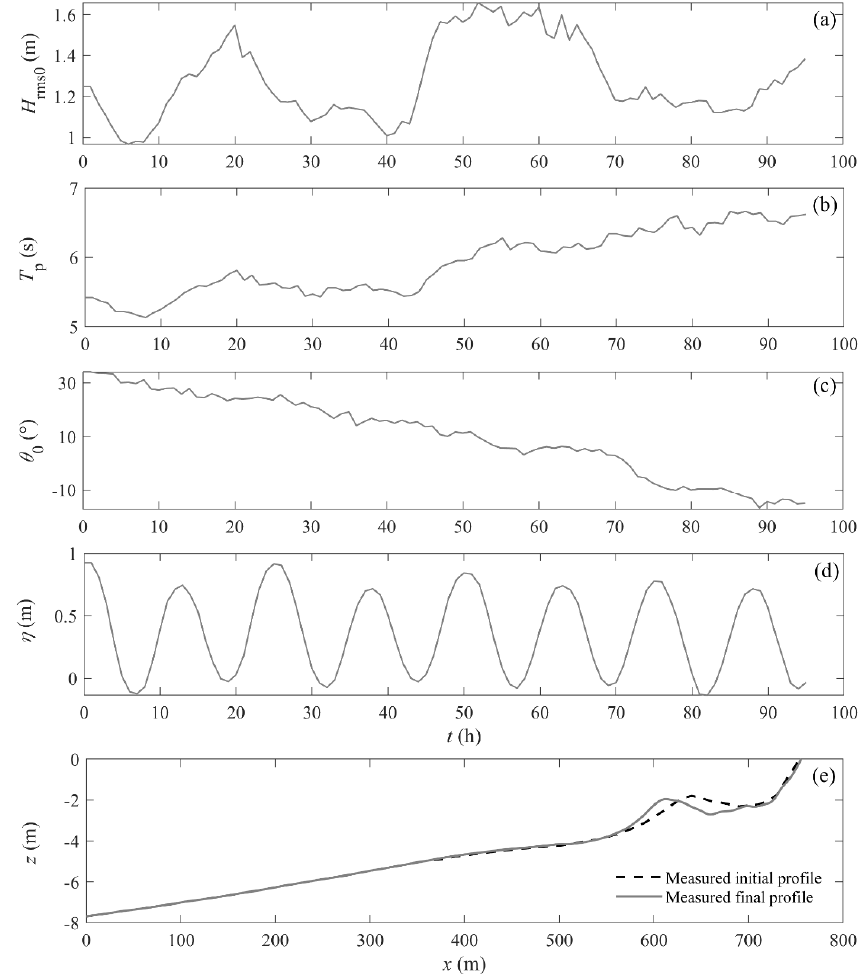
Figure 2. Time series of ( a ) RMS wave height; ( b ) wave peak period; ( c ) wave angle; ( d ) water level; ( e ) measured initial and final profiles.